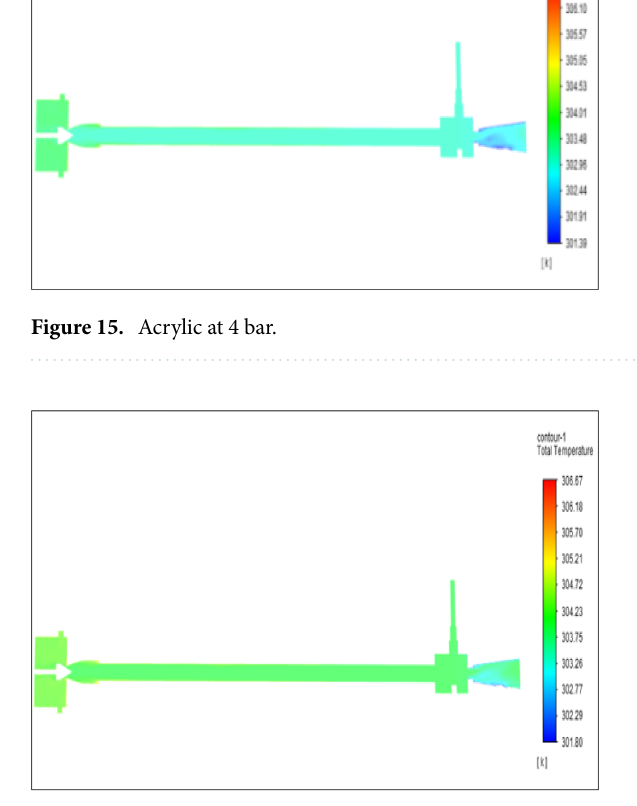
Figure 16. Nylon at 4 bar.